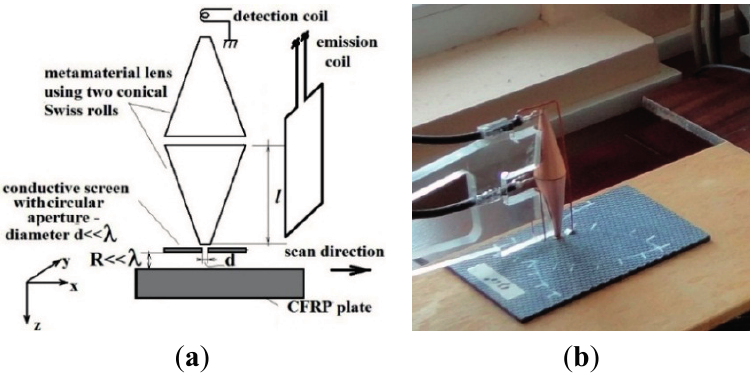
Figure 2. Sensor with MM lens: ( a ) schematic representation; ( b )